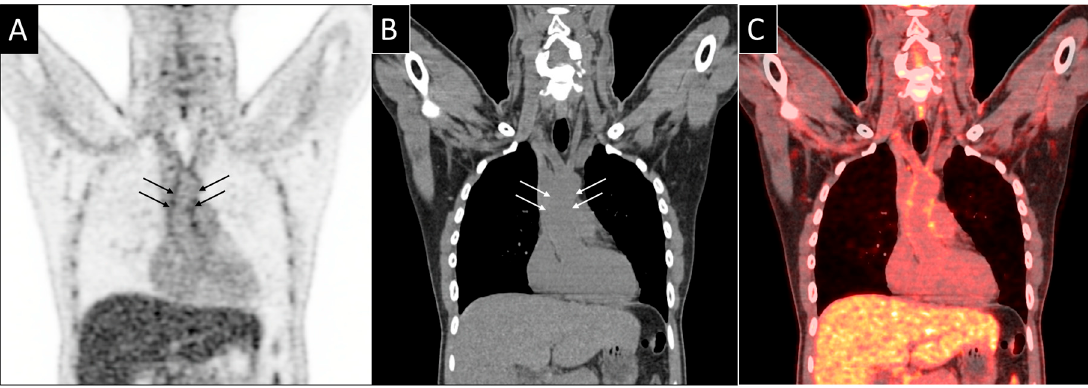
Figure 6. FDG-PET imaging of the major vessels. ( A ) Coronal FDG PET images, ( B ) coronal CT scan images and ( C ) fused PET CT scans show subtle FDG uptake in the vascular wall of the ascending aorta (arrows).